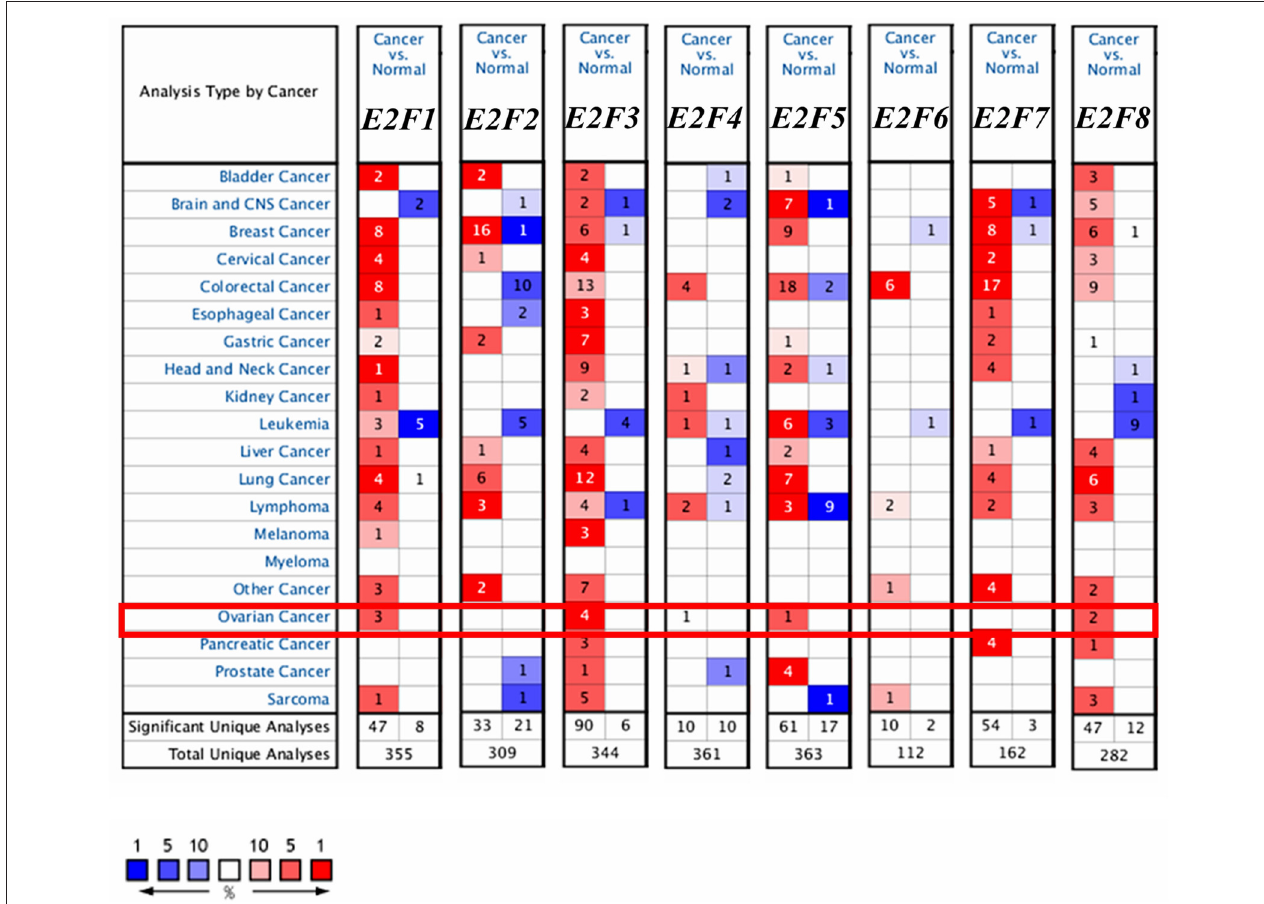
FIGURE 1 | The transcription levels of E2F family members in different types of cancers (ONCOMINE). The graph shows the numbers of datasets with statistically significant mRNA over-expression (red) or down-regulated expression (blue) of the target gene. The threshold was designed with following parameters: p -value of 1E-3 and fold change of